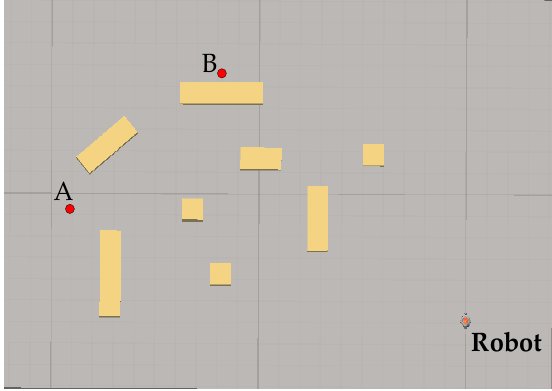
Figure 21. Flat experiment environment.